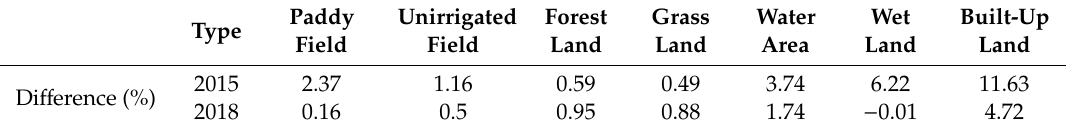
Table 10. Comparison of the prediction accuracy between the GM (1,1) model and the Markov model.